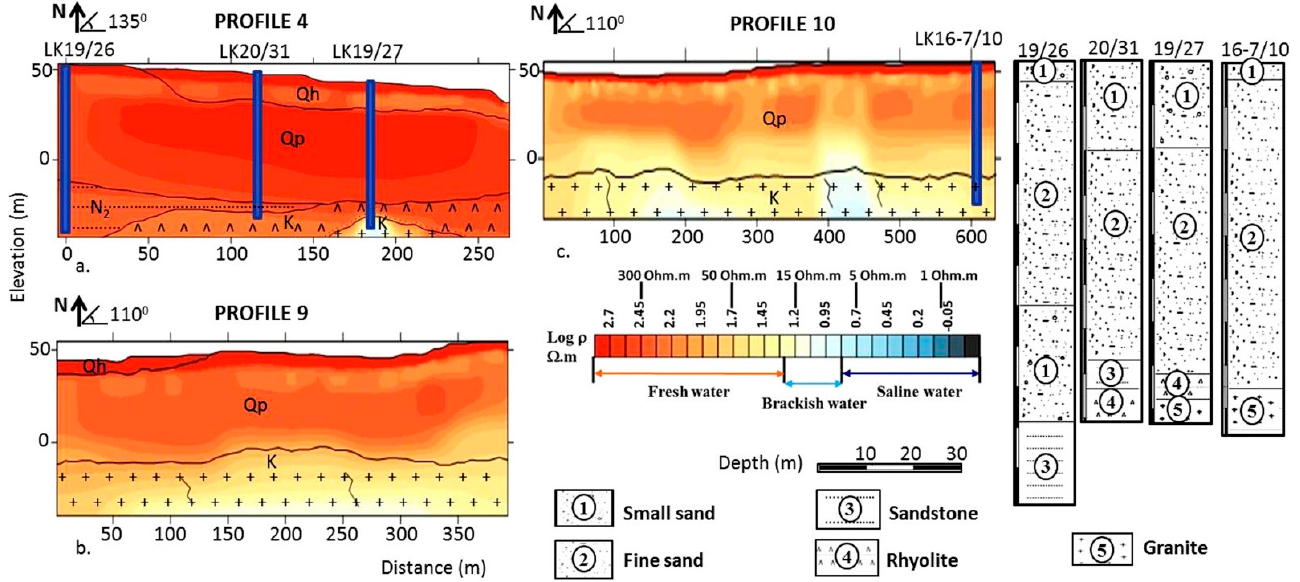
Figure 10. Resistivity distribution of representative profiles on the right bank of the upstream part. The consecutive drilled boreholes (LK 19/26, LK20/31, and LK19/27) are close to profile 4, and LK16-7/10 coincides with profile 10. The variation in resistivity of lithological layers is similar to the discrepancy in the state and structure of the sedimentary sequence and bedrock. Qh, Qp: Holocene and Pleistocene aquifers; K: Cretaceous intrusive and extrusive rocks; N 2 : Late Neogene Lien Huong formation.